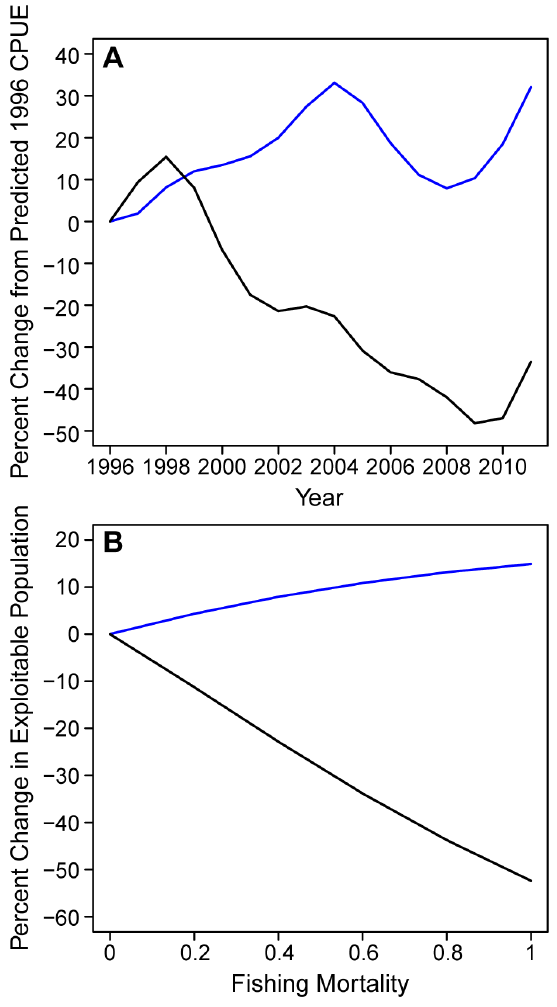
Figure 2. Percent change in standardized CPUE and population size for small and large fishes. Panels indicate ( A ) change in generalized additive model (GAM) standardized CPUE and ( B ) change in size-based model estimated population size for fishes , 15 kg (blue) and fishes $ 15 kg (black).